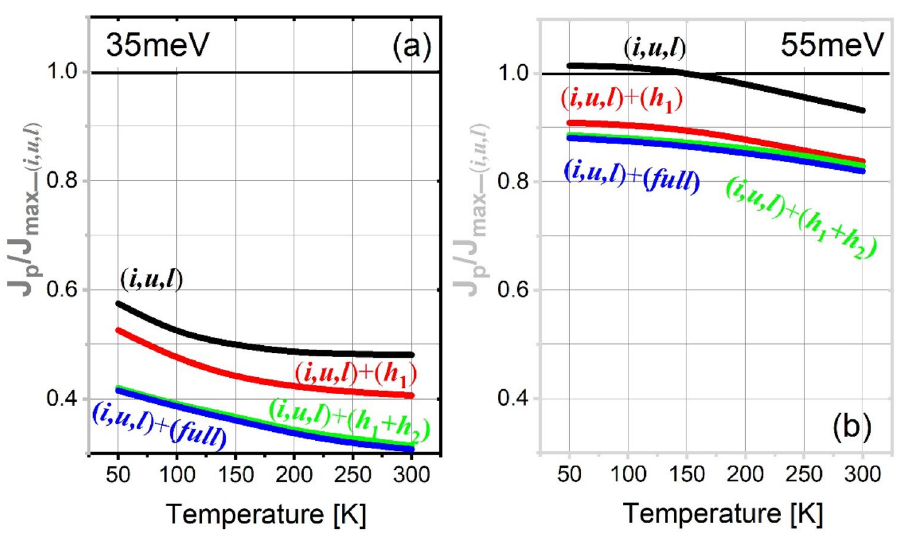
Figure 7. The J p /J max ratio as functions of the temperatures under different scale levels for both the 35 meV design ( a ) and 55 meV design ( b